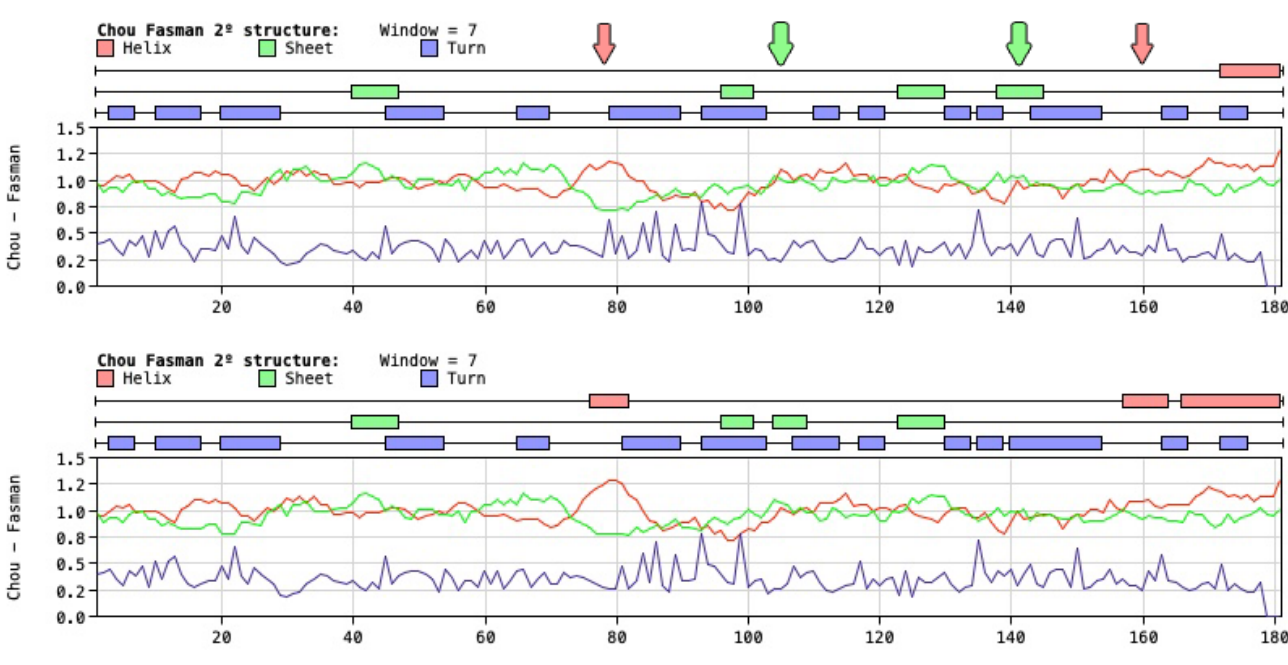
Figure 8. Secondary structure predicted for BcNF (top) compared to CNF (bottom). The differences are indicated by arrows on top of BcNF structure, using the same color as in the structural diagram.